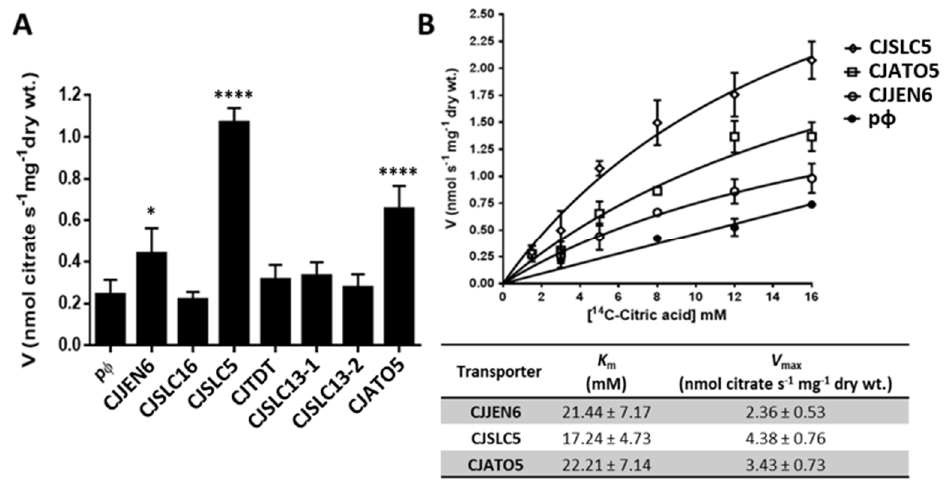
Figure 5. Citrate transport (pH 5.5, 30 °C) in S. cerevisiae IMX1000 cells expressing C. jadinii transporters. ( A ) Uptake of 14 C-citric acid 5 mM in cells expressing the transporters CjJEN6, CjSLC16, CjSLC5, CjTDT, CjSLC13-1, CjSLC13-2, and CjATO5, as well as those transformed with empty vector (p ɸ ). Statistical significance was estimated using one-way ANOVA followed by a post hoc Tukey’s multiple comparison test as follows: ∗ p < 0.1 and ∗∗∗∗ p < 0.0001, citrate uptake significantly different from cells transformed with the empty plasmid. ( B ) Initial uptake rates of radiolabeled 14 C-citric acid as a function of the acid concentration in cells expressing CjJen6, CjSlc5, and CjAto5; the table summarizes the kinetic parameters estimated with the computer-assisted non-linear regression analysis of the plots.